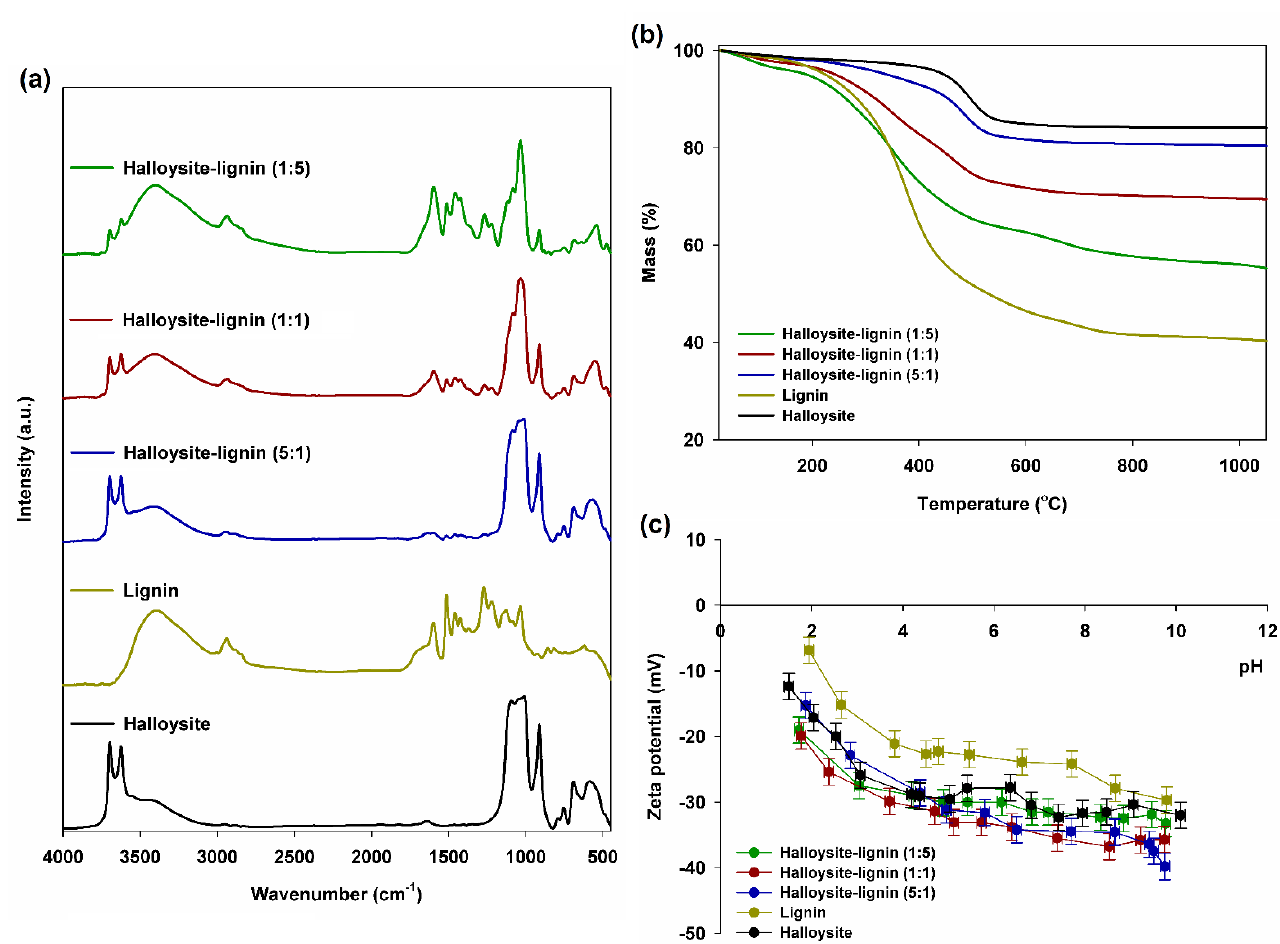
Figure 2. FTIR spectra ( a ), TGA curves ( b ) and zeta potential versus pH ( c ) of halloysite–lignin hybrid materials and pristine components.